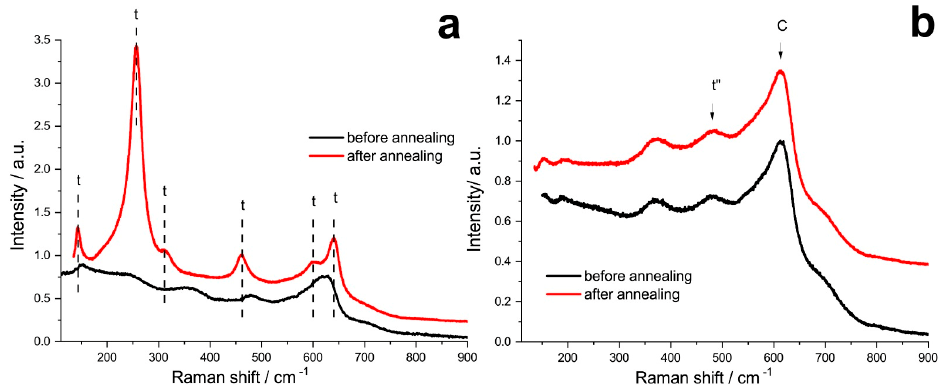
Figure 3. Raman spectra of 8Sc1GdSZ ( a ) and 10Sc1GdSZ ( b ) crystals before and after annealing. The position of the oxygen vacancies relative to the cations of the stabilizing oxides and the base cation (Zr 4+ ) was studied by analyzing the luminescence spectra. Figure 4, as an example, shows the luminescence spectra of crystals from the (ZrO 2 ) 0.99- х (Sc 2 O 3 ) х (Yb 2 O 3 ) 0.01 series before and after heat treatment due to the 5 D 0 → 7 F 0 , 5 D 0 → 7 F 1 and 5 D 0 → 7 F 2 transitions of the Eu 3+ ions. The luminescence spectra of the other crystals from the other series were similar to those of 8Sc1YbSZ and 9Sc1YbSZ.